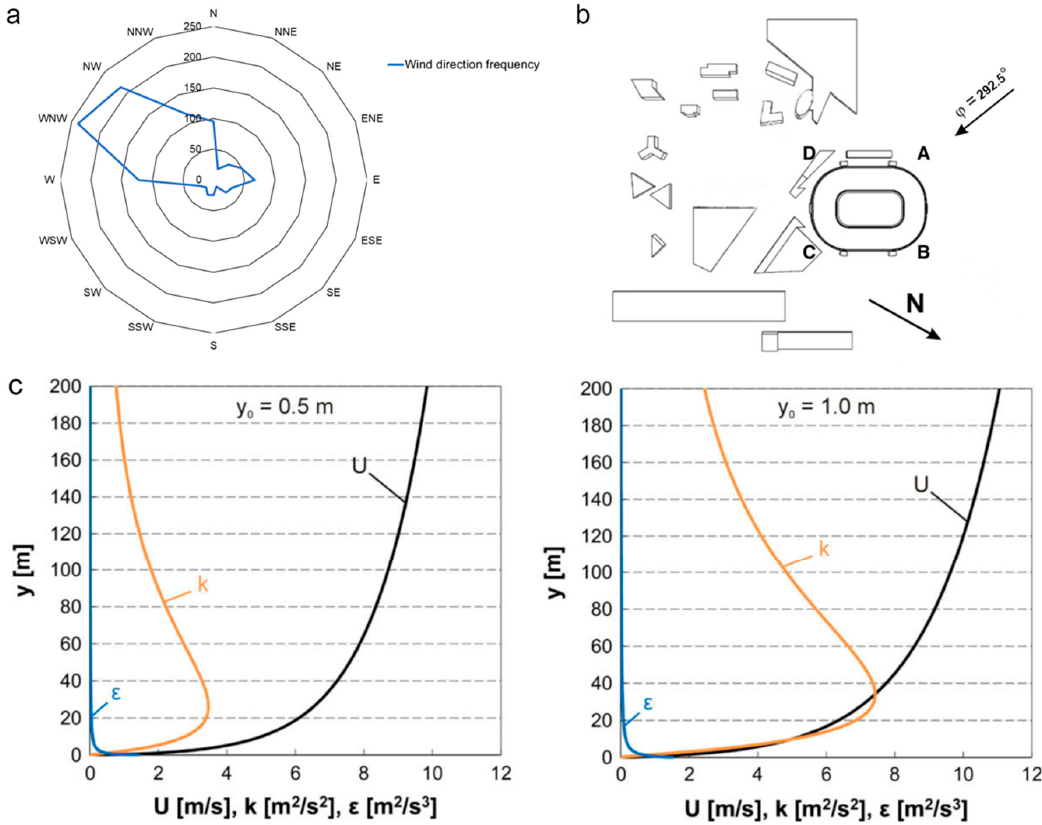
Figure 4. ( a ) Wind direction frequency for November and December in recent five years. ( b ) The winter prevailing wind direction used in the simulations (modified from [11]). ( c ) Inlet wind profiles of mean wind velocity U, turbulence kinetic energy k and turbulence dissipation rate ε for y 0 = 0.5 m and y 0 = 1 m [12].